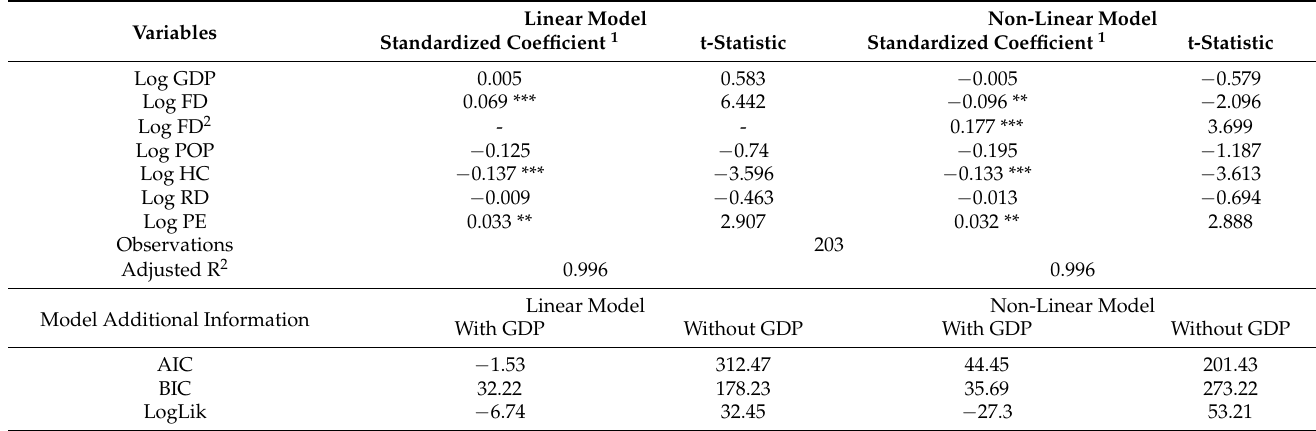
Table 6. Panel data-fixed effect regression results. Dependent variable: CO 2 .